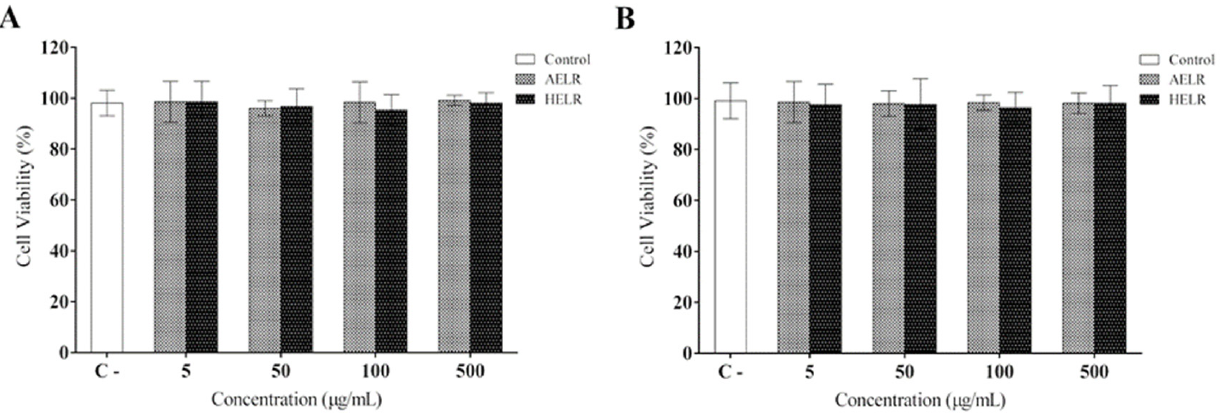
Figure 2. AELR and HELR cytotoxicity effects on RAW 264.7 murine macrophage cells: ( A ) cell viability measured by MTT assay; ( B ) cell viability measured by Alamar Blue ® assay. Culture medium DMEM was used as a negative control for cytotoxicity.